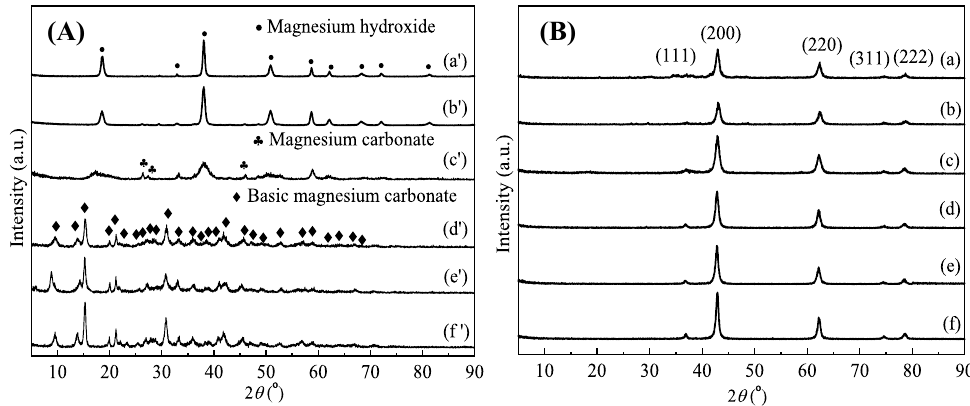
Figure 3. XRD patterns of the dried precursors ( A ) and the calcined catalysts ( B ). ( A ): (a’) MgO-P-NaOH-3- Pre, (b’) MgO-P-NaOH-6-Pre, (c’) MgO-P-NaOH + Na 2 CO 3 -3/1-Pre, (d’) MgO-P-NaOH + Na 2 CO 3 -1/3-Pre, (e’) MgO-P-Na 2 CO 3 -3-Pre, and (f’) MgO-P-Na 2 CO 3 -3.14-Pre. ( B ): (a) MgO-P-NaOH-3, (b) MgO-P-NaOH-6, (c) MgO-P-NaOH + Na 2 CO 3 -3/1, (d) MgO-P-NaOH + Na 2 CO 3 -1/3, (e) MgO-P-Na 2 CO 3 -3, and (f) MgO-P- Na 2 CO 3 -3.14.